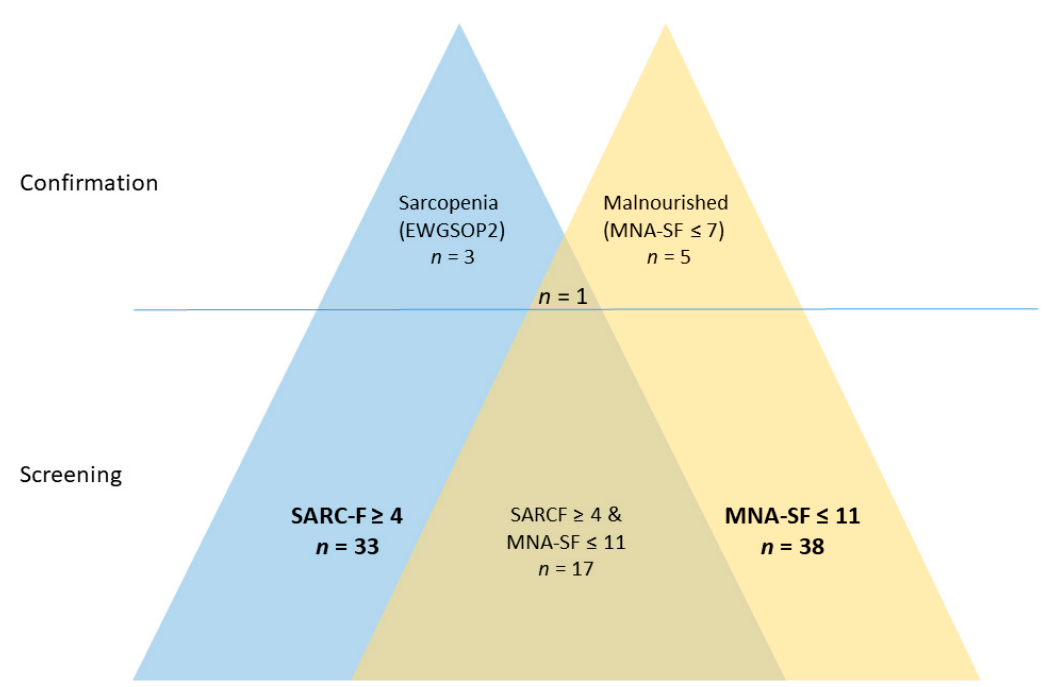
Figure 2. Number of patients with indicative findings in either or both of the two screening questionnaires (SARC-F and MNA-SF) and those with confirmed sarcopenia/malnutrition.